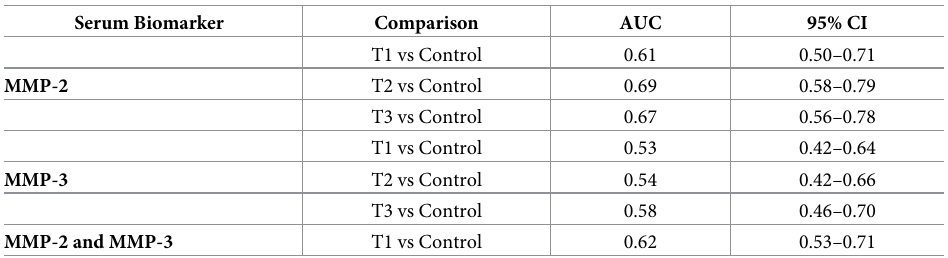
Table 2. Discriminative performance of serum MMP-2 and MMP-3. Serum